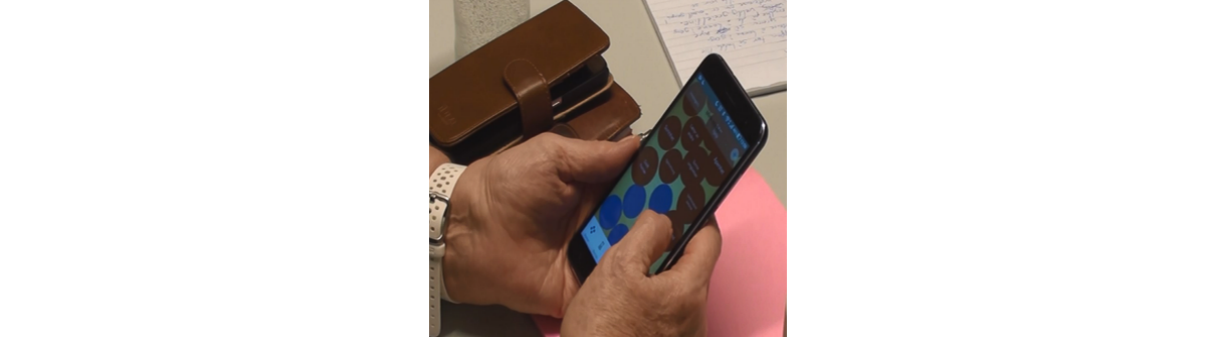
Figure 5. User evaluating the app (capture from